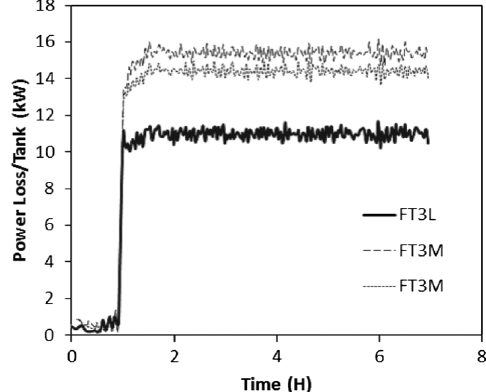
FIG. 9. Power consumption in a half cavity cell calculated by temperature rise of cooling water during machine operation. The gap voltage was 11.7 kV during the measurements. Because of the higher impedance compared to the other cavities, the tem- perature rise of the FT3L cavity cell (bold line) is much lower than that of the other FT3M cavity cells (dashed and dotted lines). The temperature and flow rate has 5%–7% and 5% errors, respectively. The power consumption in the FT3L cell is consistent with the cavity impedance measurements.